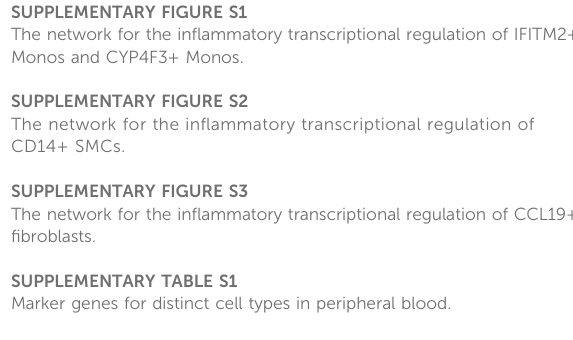
SUPPLEMENTARY TABLE S2 Marker genes for distinct cell types in muscle.